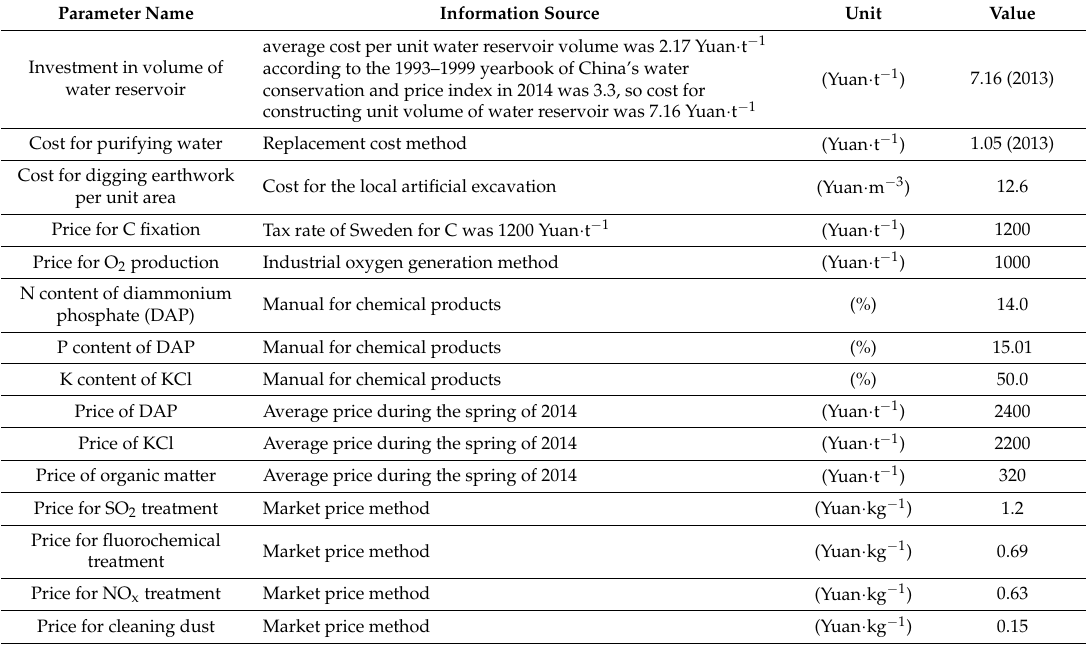
Table A1. Price parameters of Forest ecosystem service